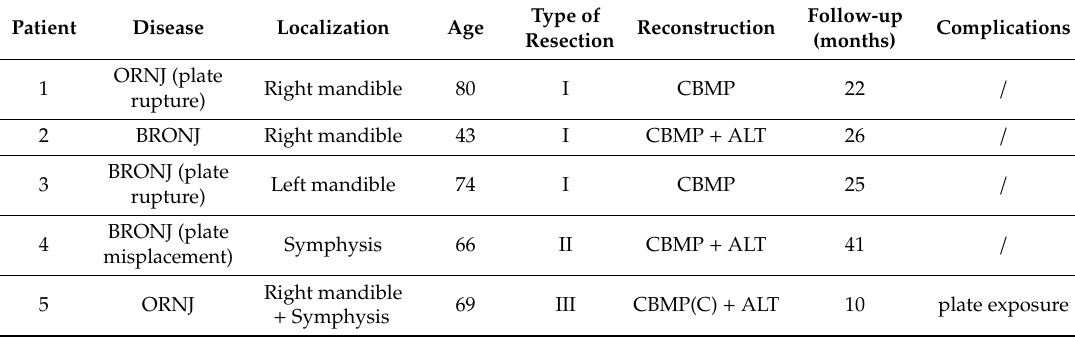
Table 1. Patient characteristics overview.